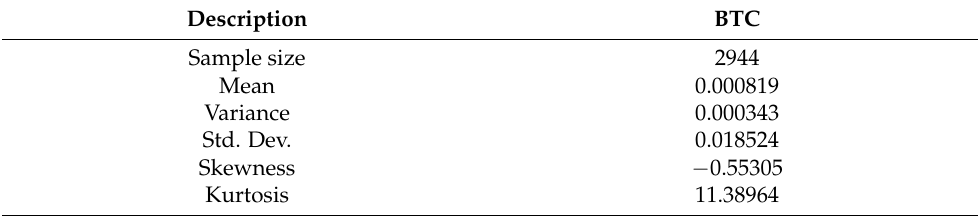
Figure 1. Bitcoin daily return and bitcoin daily squared return. ( a ) Bitcoin daily return; ( b ) bitcoin squared daily return. Table 1. Summary Statistics of Bitcoin Daily Returns in the Sample Period.